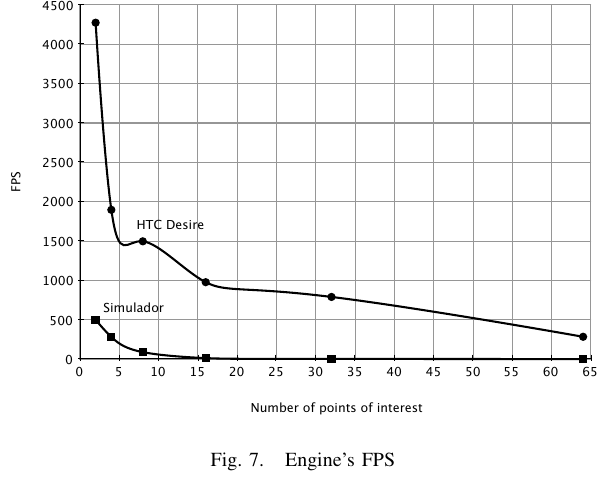
Fig. 7. Engine’s FPS